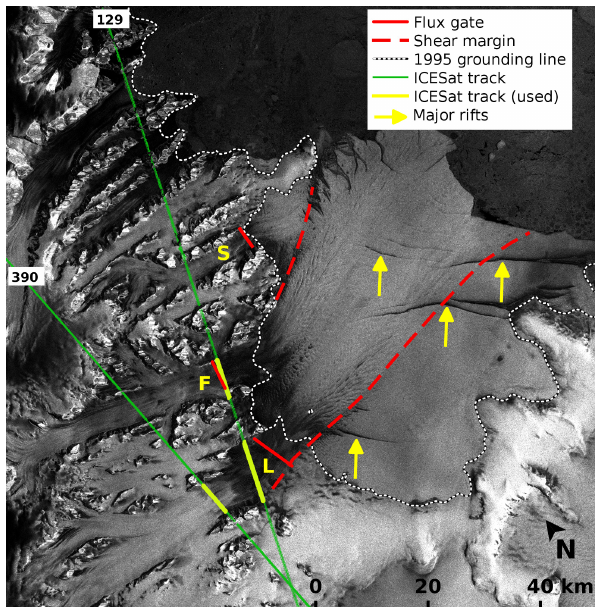
Figure 5. Envisat ASAR image of Scar Inlet ice shelf and tributary glaciers, 28 January 2004. Red lines show the flux gates for Flask (F), Leppard (L) and Starbuck (S) glaciers. The broken red lines delimit the outflow downstream of Flask and Leppard glaciers. The yellow sections of the ICESat tracks are used for deriving surface elevation change on Leppard and Flask glaciers. The arrows point to major